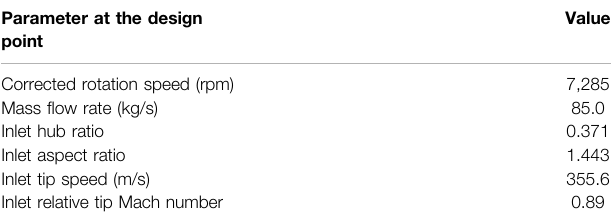
TABLE 1 | Main parameters of the nine-stage axial compressor.